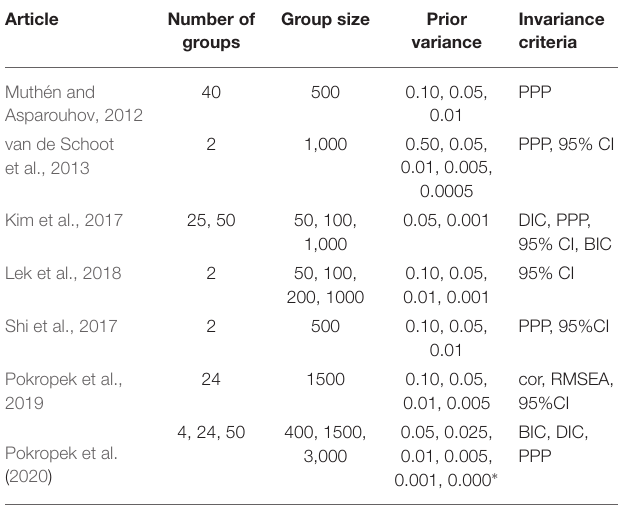
TABLE 3 | Simulation studies using Bayesian approximate measurement